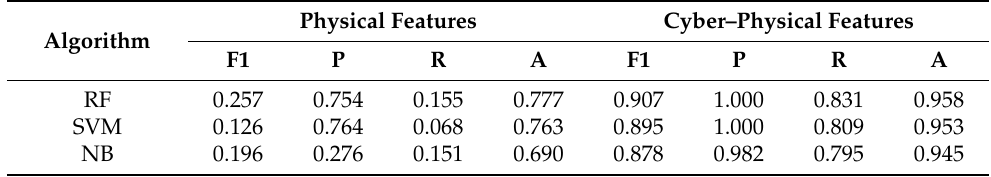
Table 6. Performance of three supervised machine learning